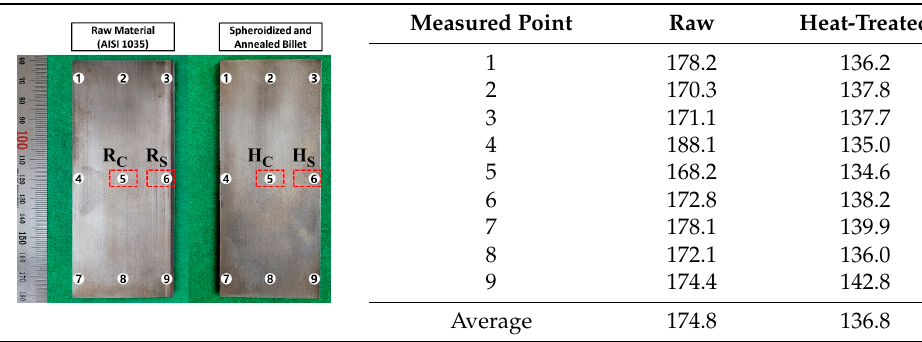
Table 6. Measured Vickers micro-hardness before and after spheroidizing-annealing of AISI 1035 workpiece material (unit: HV 25 ).